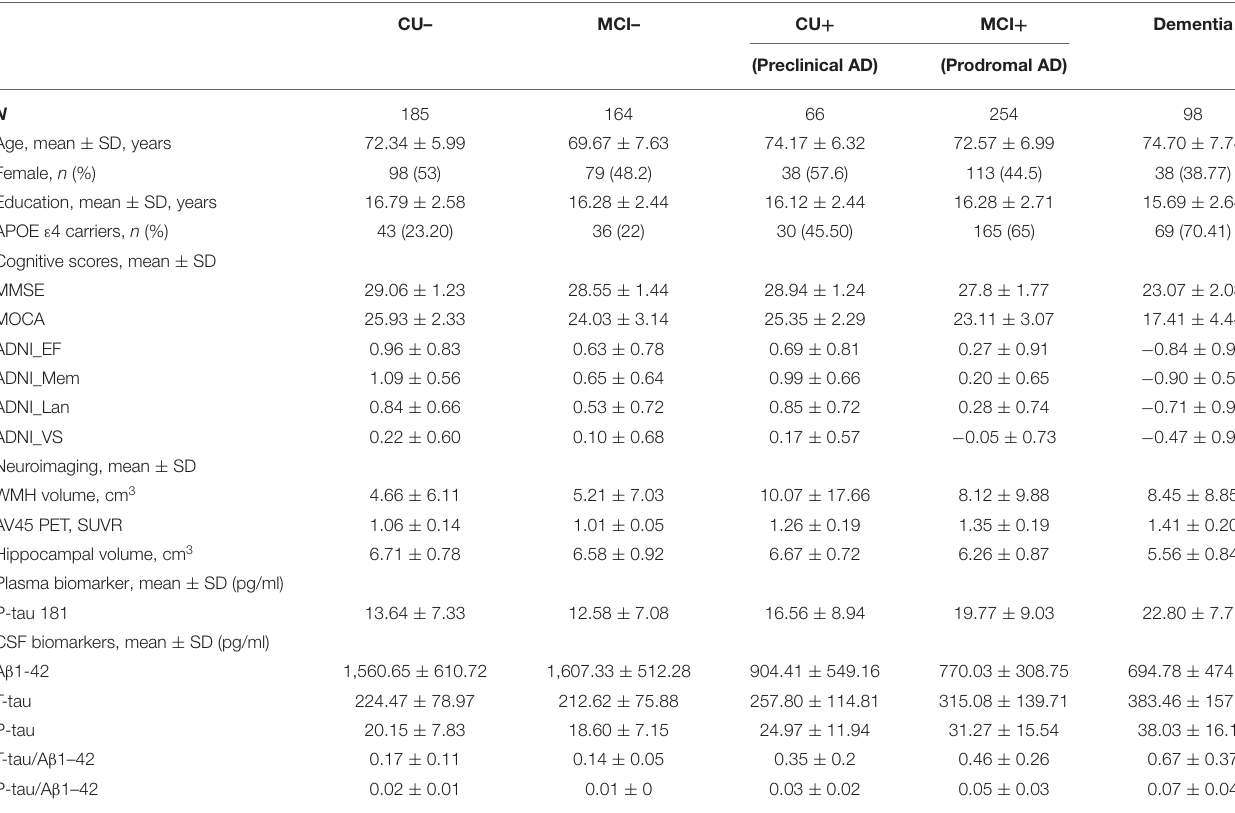
TABLE 1 | Demographic and clinical characteristics of participants.